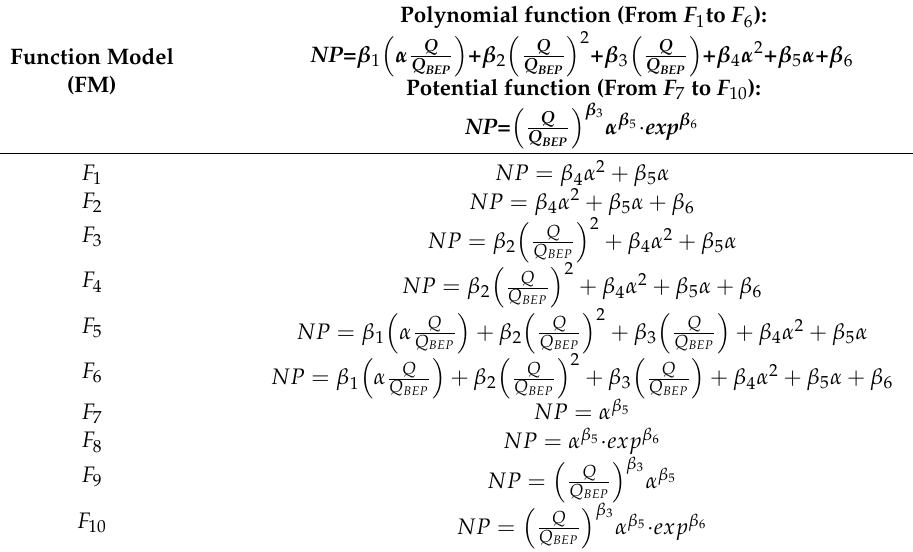
Table 3. Proposed functions to be analysed.